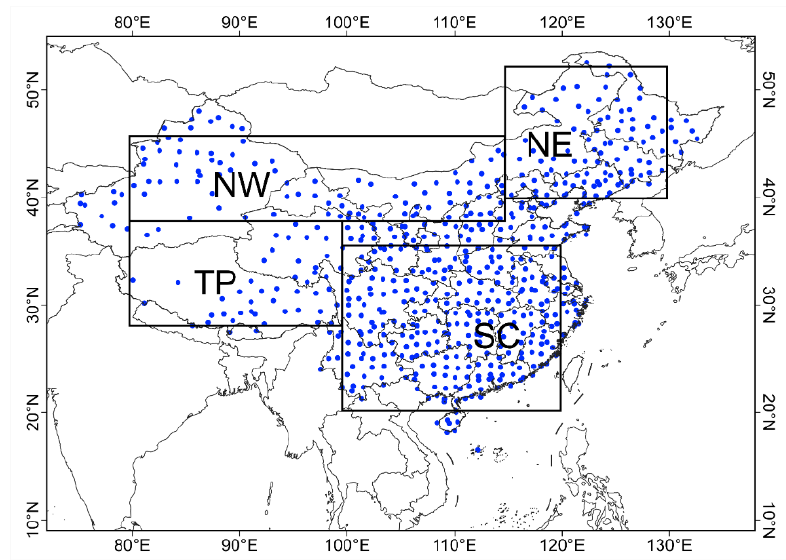
Figure 1. The spatial distribution of the 614 ground sites in China. The blue dots represent the location of each site. The acronyms in black represent the major regions of China. NW: northwestern region (38°N – 46° N, 80°E – 115° E); NE: northeastern region (40°N – 52° N, 115°E – 130° E); TP: Tibetan Plateau region (28°N – 38° N, 80°E – 100° E); SC: southern China (20°N – 35° N, 100°E – 120° E). The blue dots represent the location of each site.